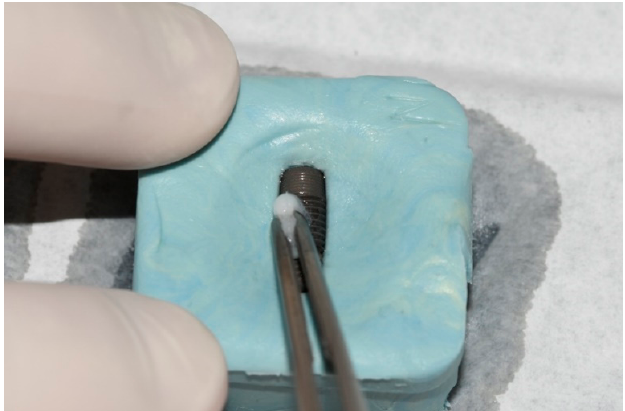
Figure 3. Decontamination of implant surface with sterile cotton pellet soaked in 0.2% chlorhexidine ‐ based solution.